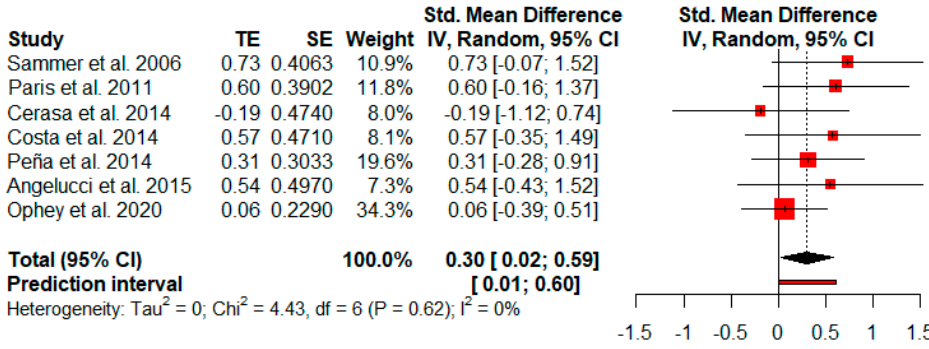
Figure 9. Effectiveness of cognitive rehabilitation in executive Figure 9 . Effectiveness of cognitive rehabilitation in executive functions.